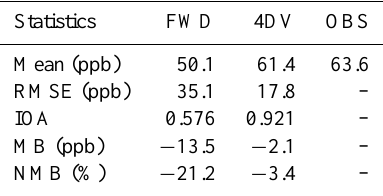
Table 5. Statistics for the observed (OBS) and simulated (FWD and 4DV) results. The FWD indicates the simulation without data as- similation. 4DV results are obtained by assimilating all observed surface O 3 with realized background error covariance matrix dur- ing 12h time